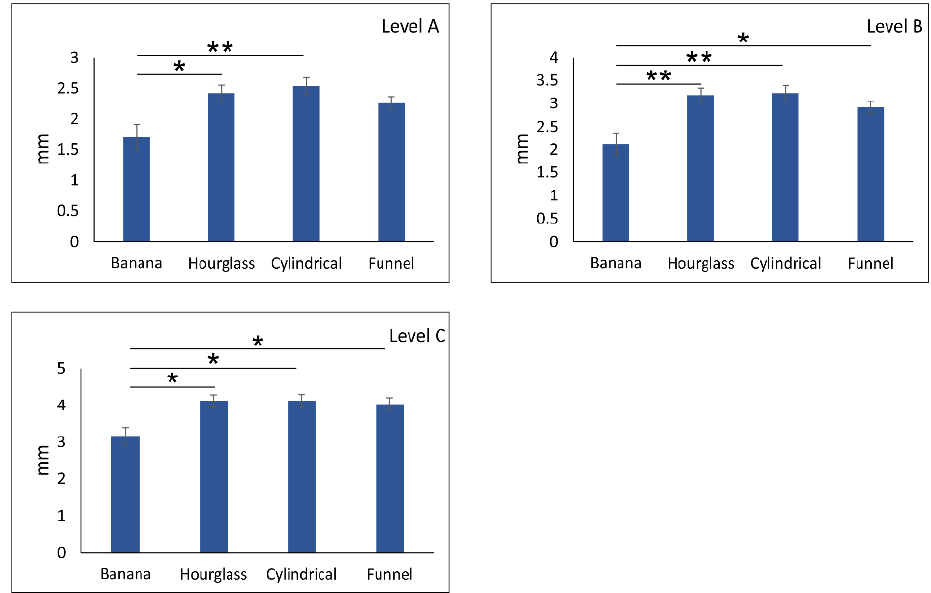
Figure 6. The impact of NPC type on distance between central incisors and NPC at different sections of anterior maxilla ( A ) level A, ( B ) level B, and ( C ) level C. Bars represent the mean ± SEM. * denotes a significant difference of p < 0.05; ** denotes a significant difference of p < 0.01.